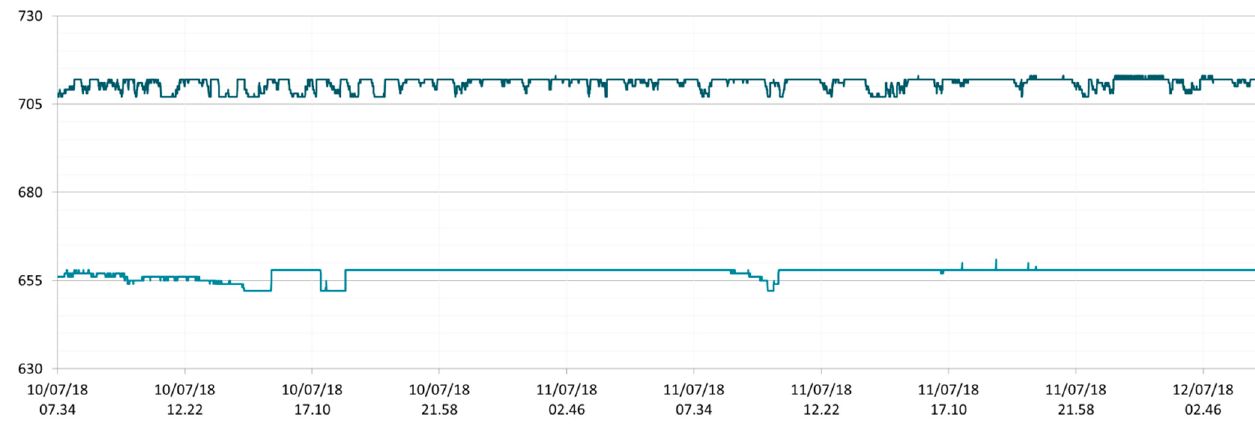
Figure 10. Zoom of the raw patterns of valve openings of two individuals of P. casertanum included in the second study group, from 10 to 12 July 2018: HUB03-01 in blue colour, HUB03-02 in heavenly colour.